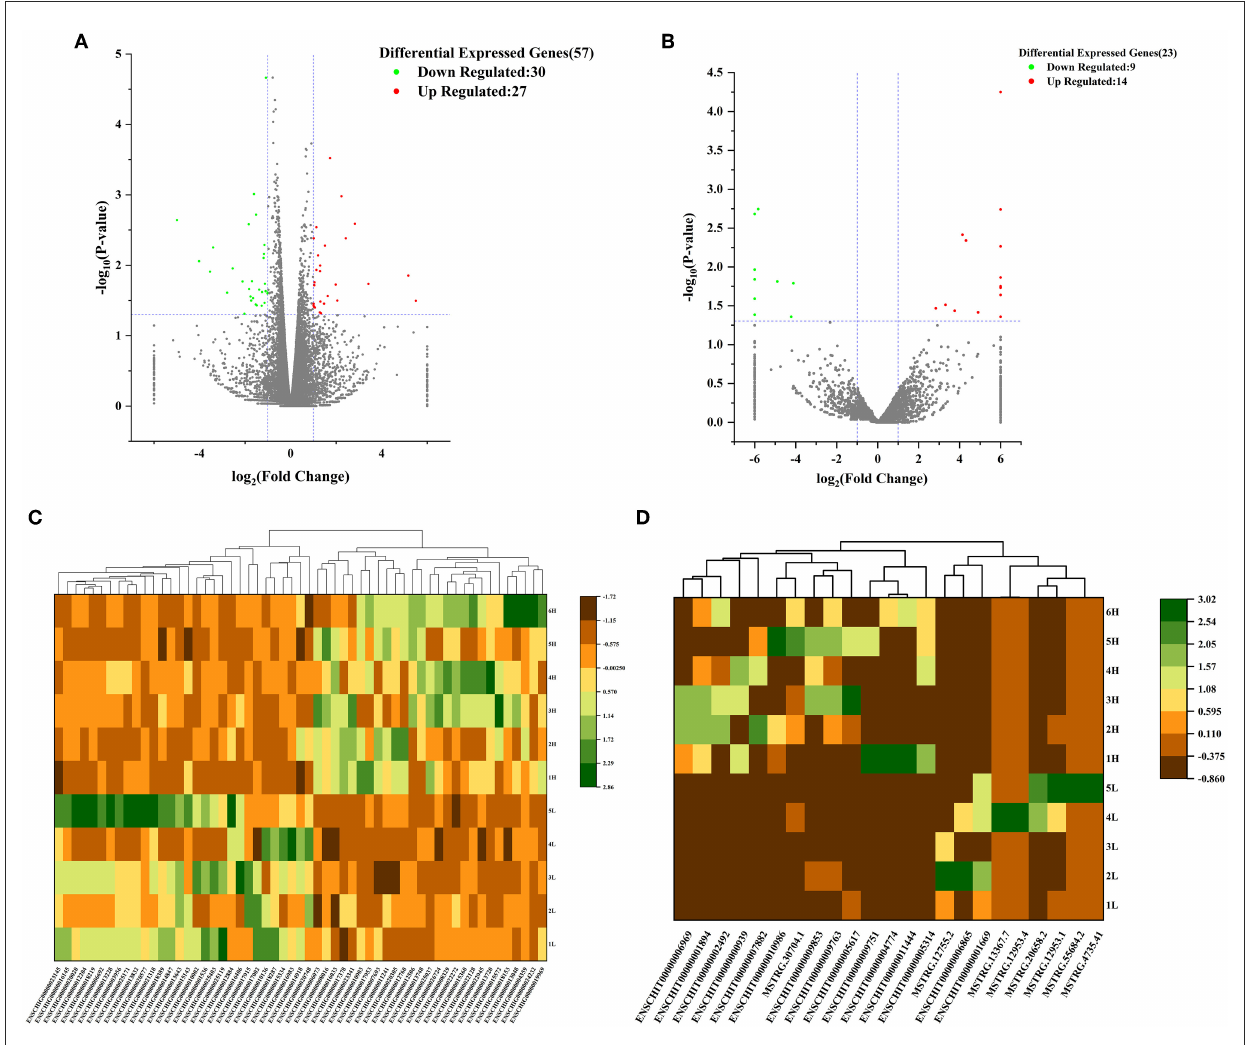
FIGURE1 Volcano analysis of (A) mRNA and (B) lncRNA between HFG and LFG in the hypothalamus; Cluster heat map of (C) DEmRNAs and (D) DElncRNAs between HFG and LFG in the hypothalamus.